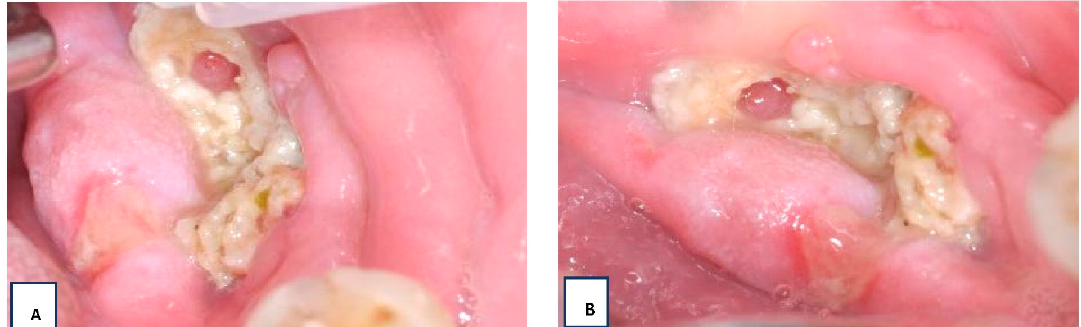
Figure 1. Medication (bisphosphonate)-Related Osteonecrosis of the Jaw (MRONJ). ( A , B ) A necrotic exposed bone on the left posterior alveolar ridge of the mandible with traumatic ulcer on the lingual side.